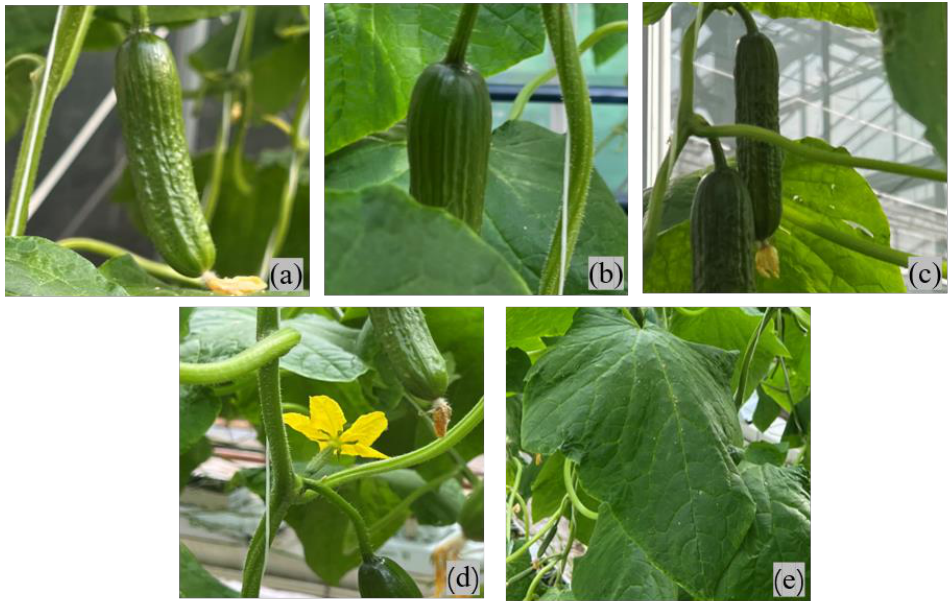
Figure 2. Positive labels ( a – c ) with different degrees of occlusion and negative labels ( d , e ). For each category: ( a ) intact cucumber; ( b ) partial cucumber occluded by leaves; ( c ) cucumber sliced by stems or petioles; ( d ) female flower; and ( e ) leaves and